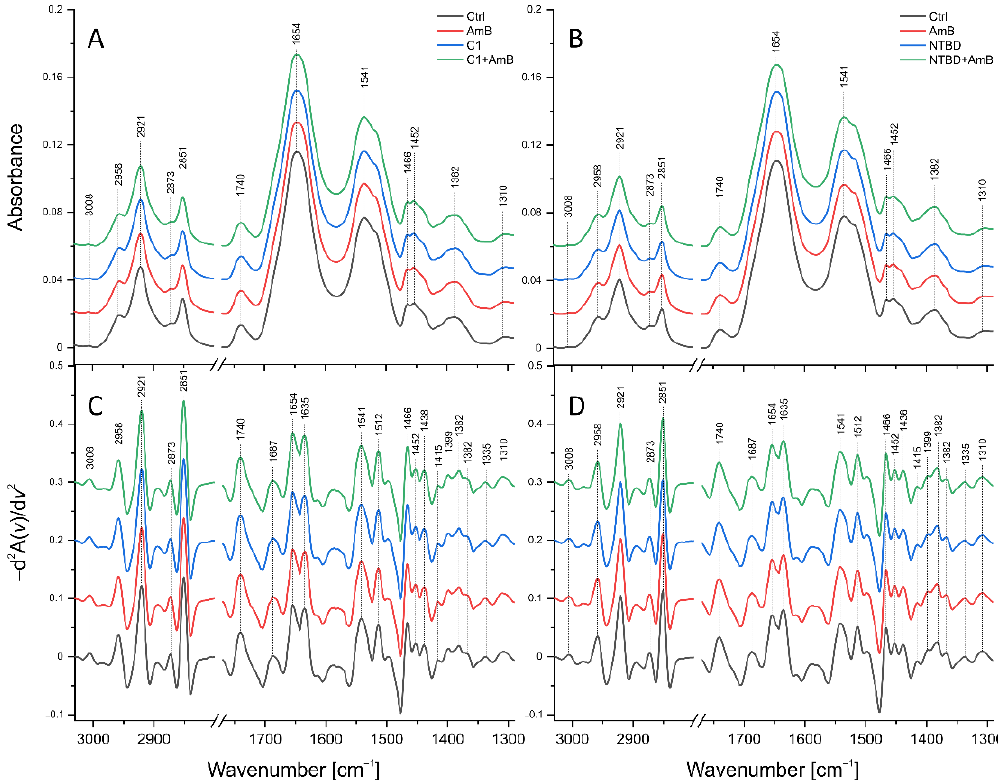
Figure 8. Mean ATR-FTIR spectra of RPTEC cells: ( A ) — control, treated with AmB (0.03 ug/mL), C1 (8 ug/mL), and their mixture; ( C ) — reversed second derivatives of spectra presented in ( A ); ( B ) — control, treated with AmB (0.06 ug/mL), NTBD (4 ug/mL), and their mixture; ( D ) — reversed second derivatives of spectra presented in ( B ). Table 1. Characterization of IR bands and band ratios analyzed in the ATR-FTIR study of RPTECs [31,36,43,47 – 54].